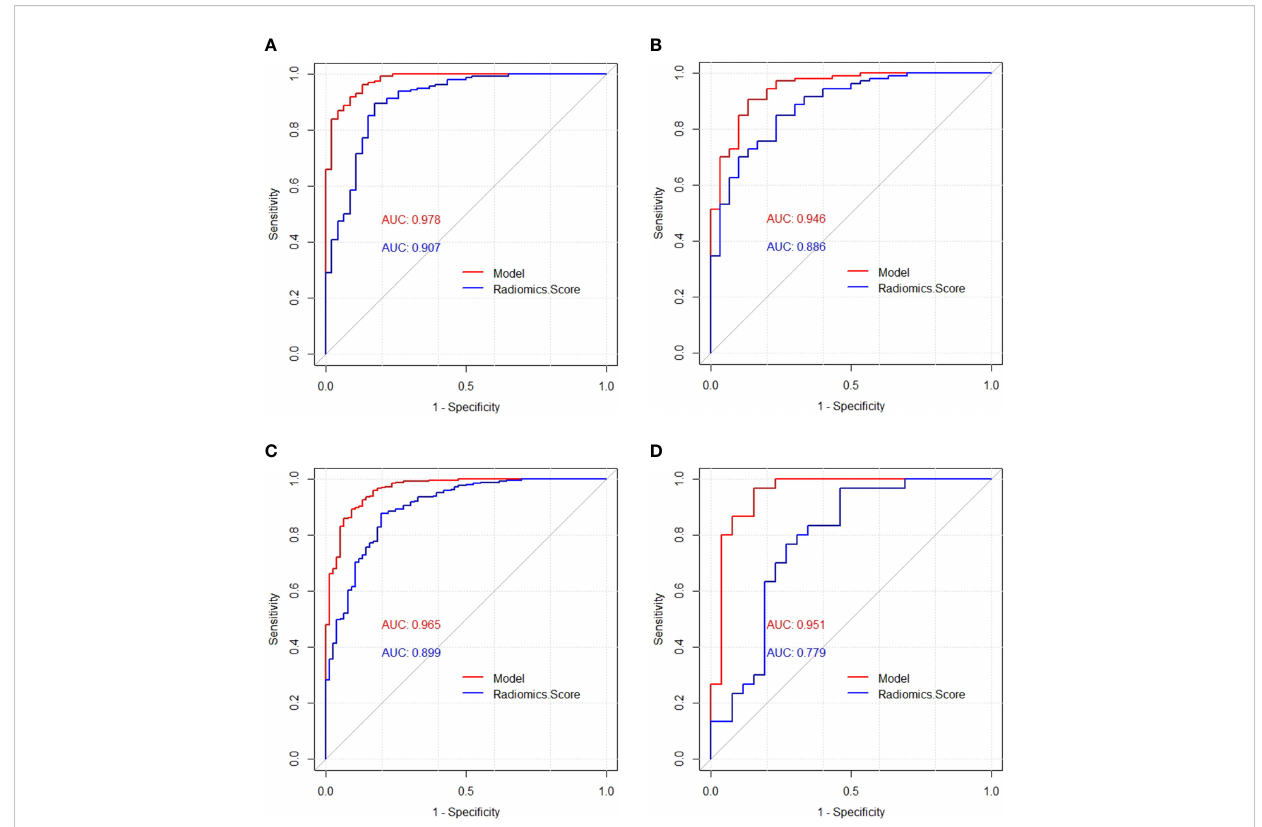
FIGURE 5 Receiver operating characteristic (ROC) curves of the model and radiomics score in the training cohort (A) , validation cohort (B) , total dataset (C) and independent validation cohort (D) ,